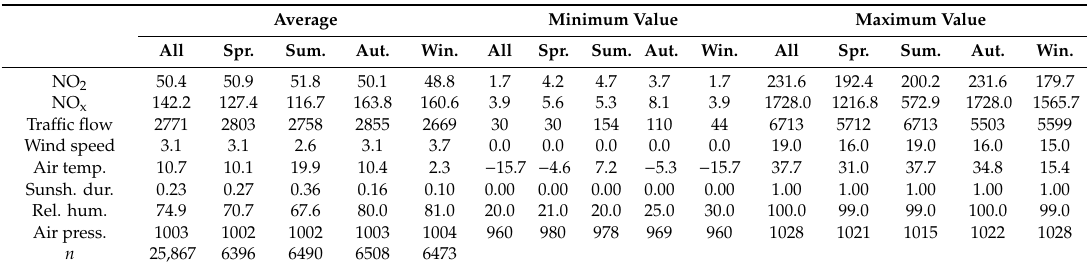
Table 1. Descriptive statistics for independent variables by